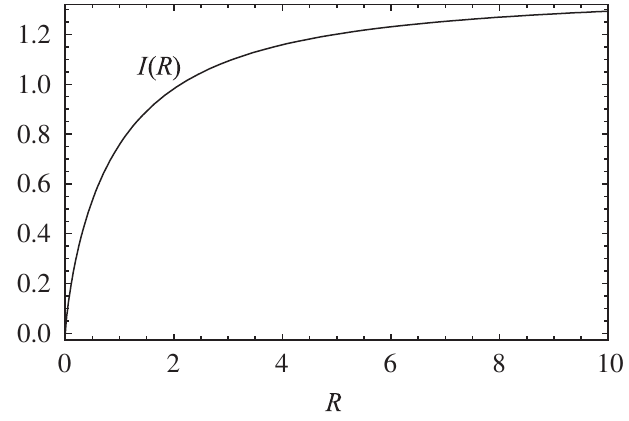
R dRe R 2 = 4 (cid:1) ð 0 ; R 2 = 4 Þ = 4